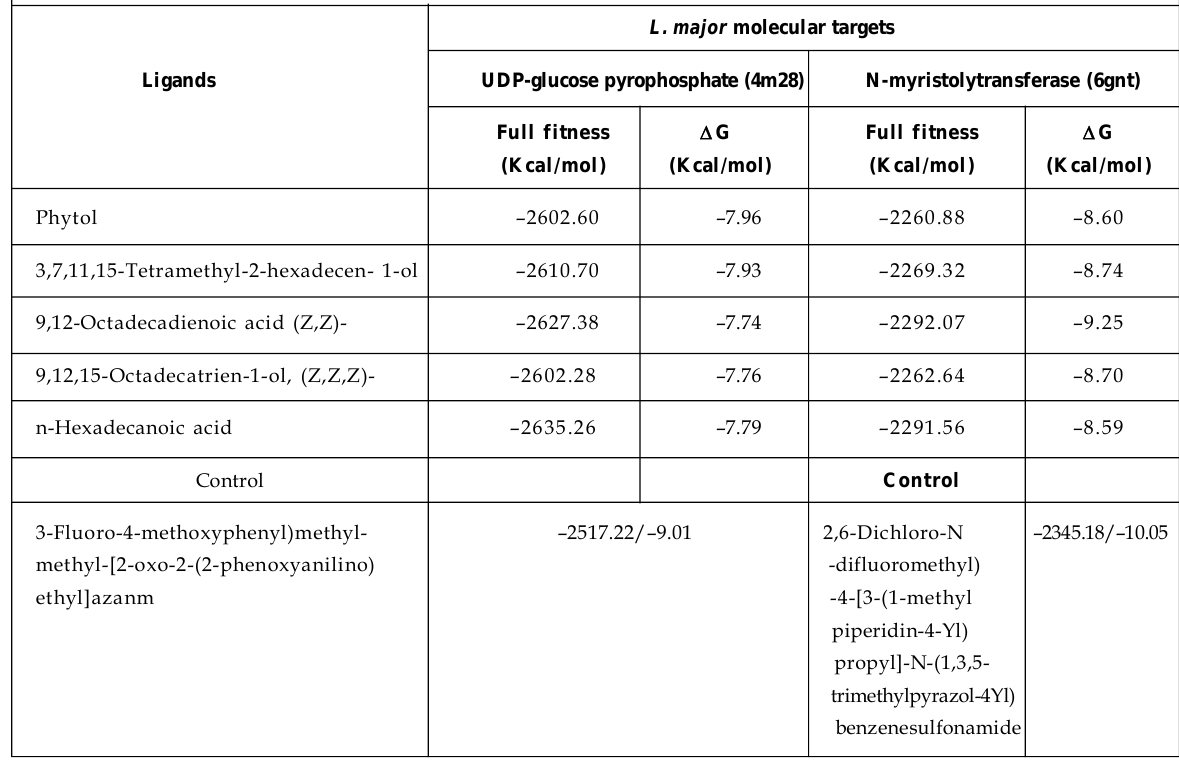
Table 5: Docking result of L. major molecular drug targets